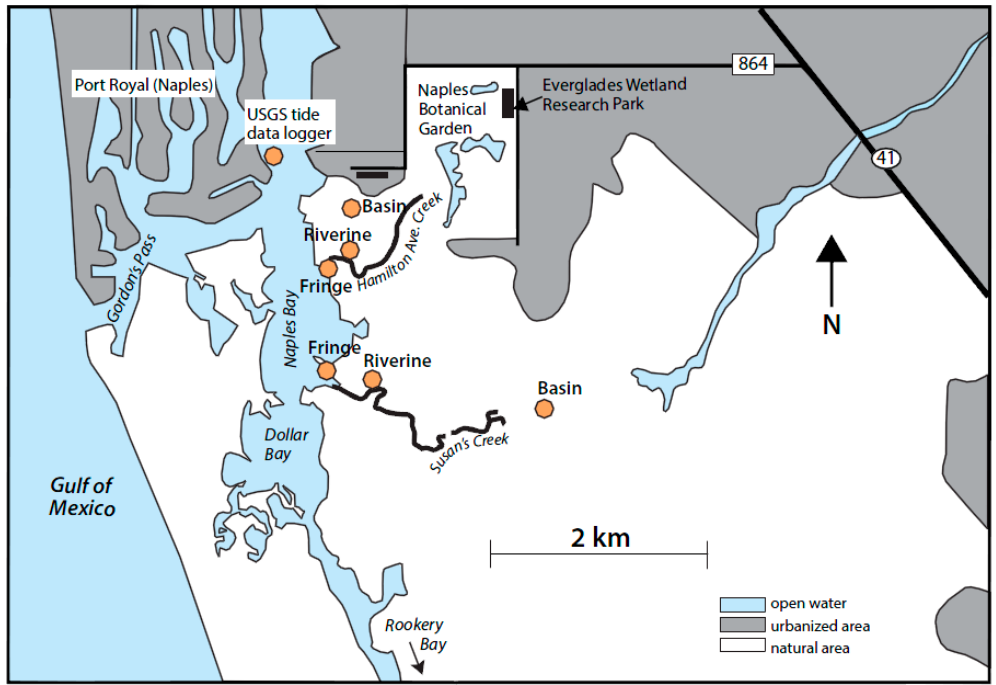
Figure 1. Map detailing study locations in south Naples, Florida near the Gulf of Mexico, of the two mangrove tidal creeks used in this study: disturbed Hamilton Avenue Creek and reference Susan’s Creek. Also shown are the specific locations of the three hydrogeomorphic settings for mangrove soil sampling near, or on, each of the two tidal creeks. Locations of Naples/Dollar Bays, Gulf of Mexico, the Naples Botanical Garden, and the Everglades Wetland Research Park are also shown.